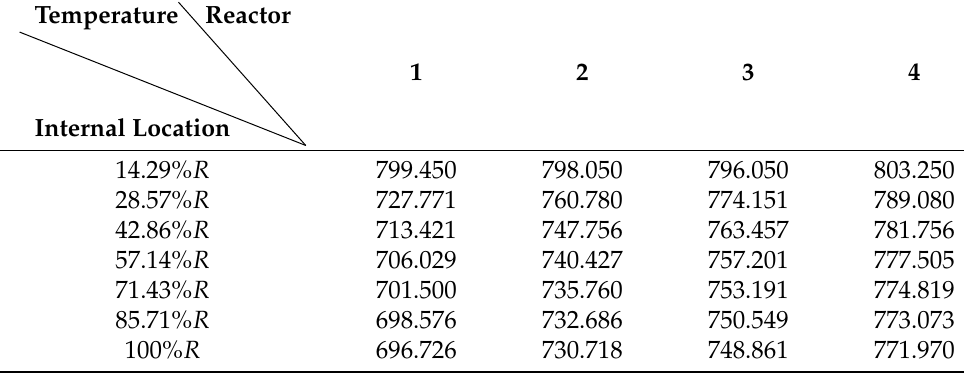
Table 2. Discrete model dynamic simulation of reactor temperature